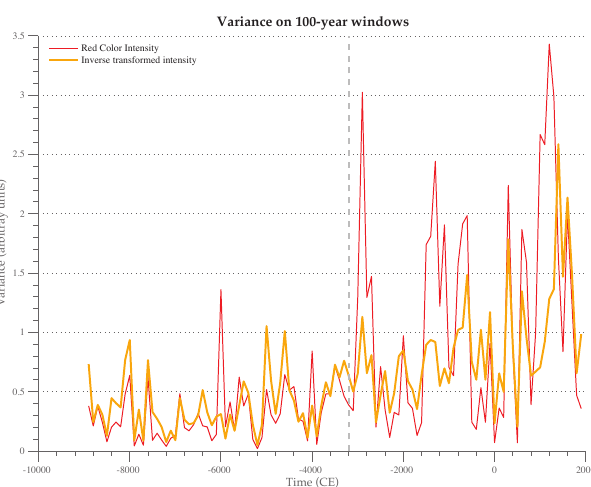
Figure 8. Variances calculated over non-overlapping 100-year seg- ments of the Pallcacocha red colour intensity record (thick cyan line) and after applying the empirical transform (thin blue line). Both series were standardized prior to